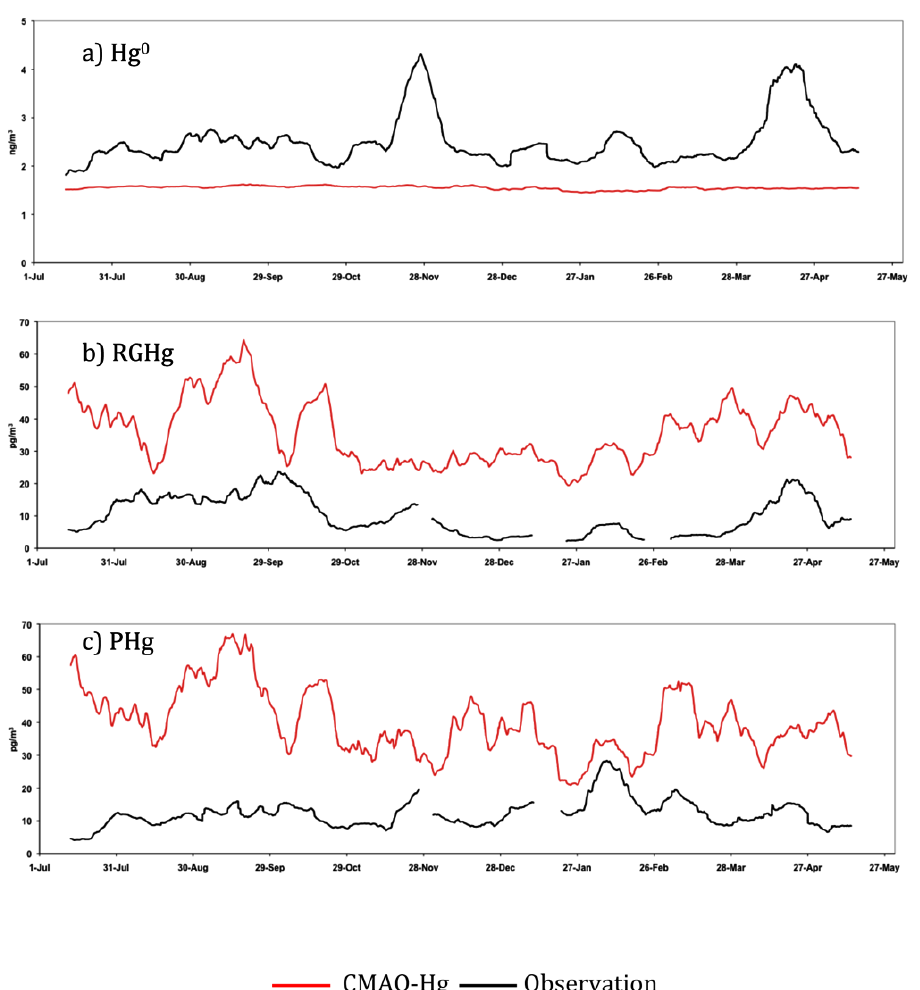
Fig. 3. Comparison of CMAQ-Hg simulated ambient mercury species against observed values at the urban MKE site for Hg 0 ( a , units ngm − 3 ) , RGHg ( b , units pgm − 3 ) , and PHg ( c , units pgm − 3 ) . Values reflect a 14-day running average. Observed data spans 2004–2005; model data taken from a 2003 annual